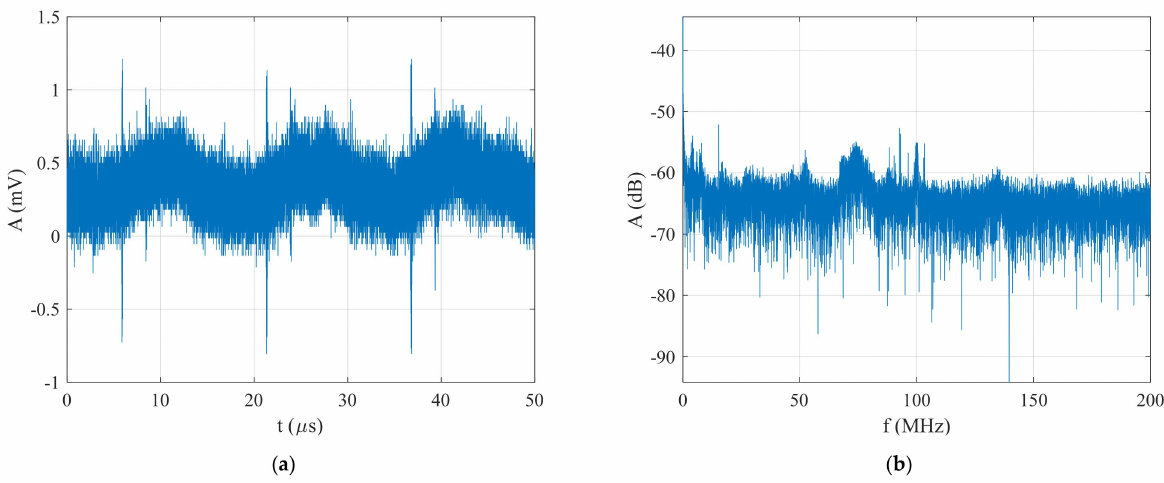
Figure 9. The generated BPSK signal in the form of Barker Code 7 at an SNR = − 21 dB : ( a ) time domain, and ( b ) spectrum.